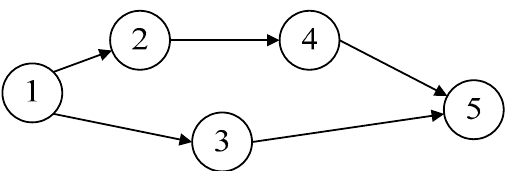
Figure 1. Topology model of fine-grained task partitioning.